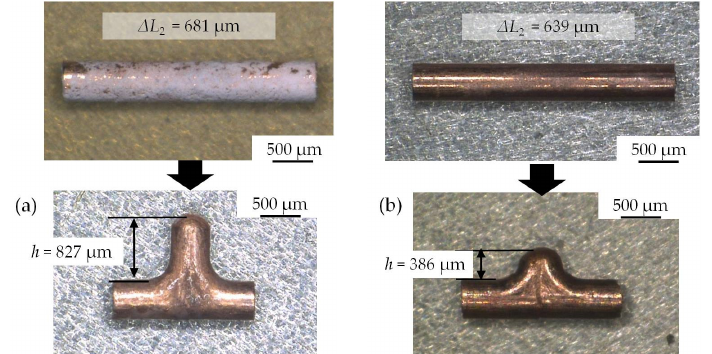
Figure 13. Effect of lubrication condition on the hydroformability (bulge height) of T ‐ shape MTHF: